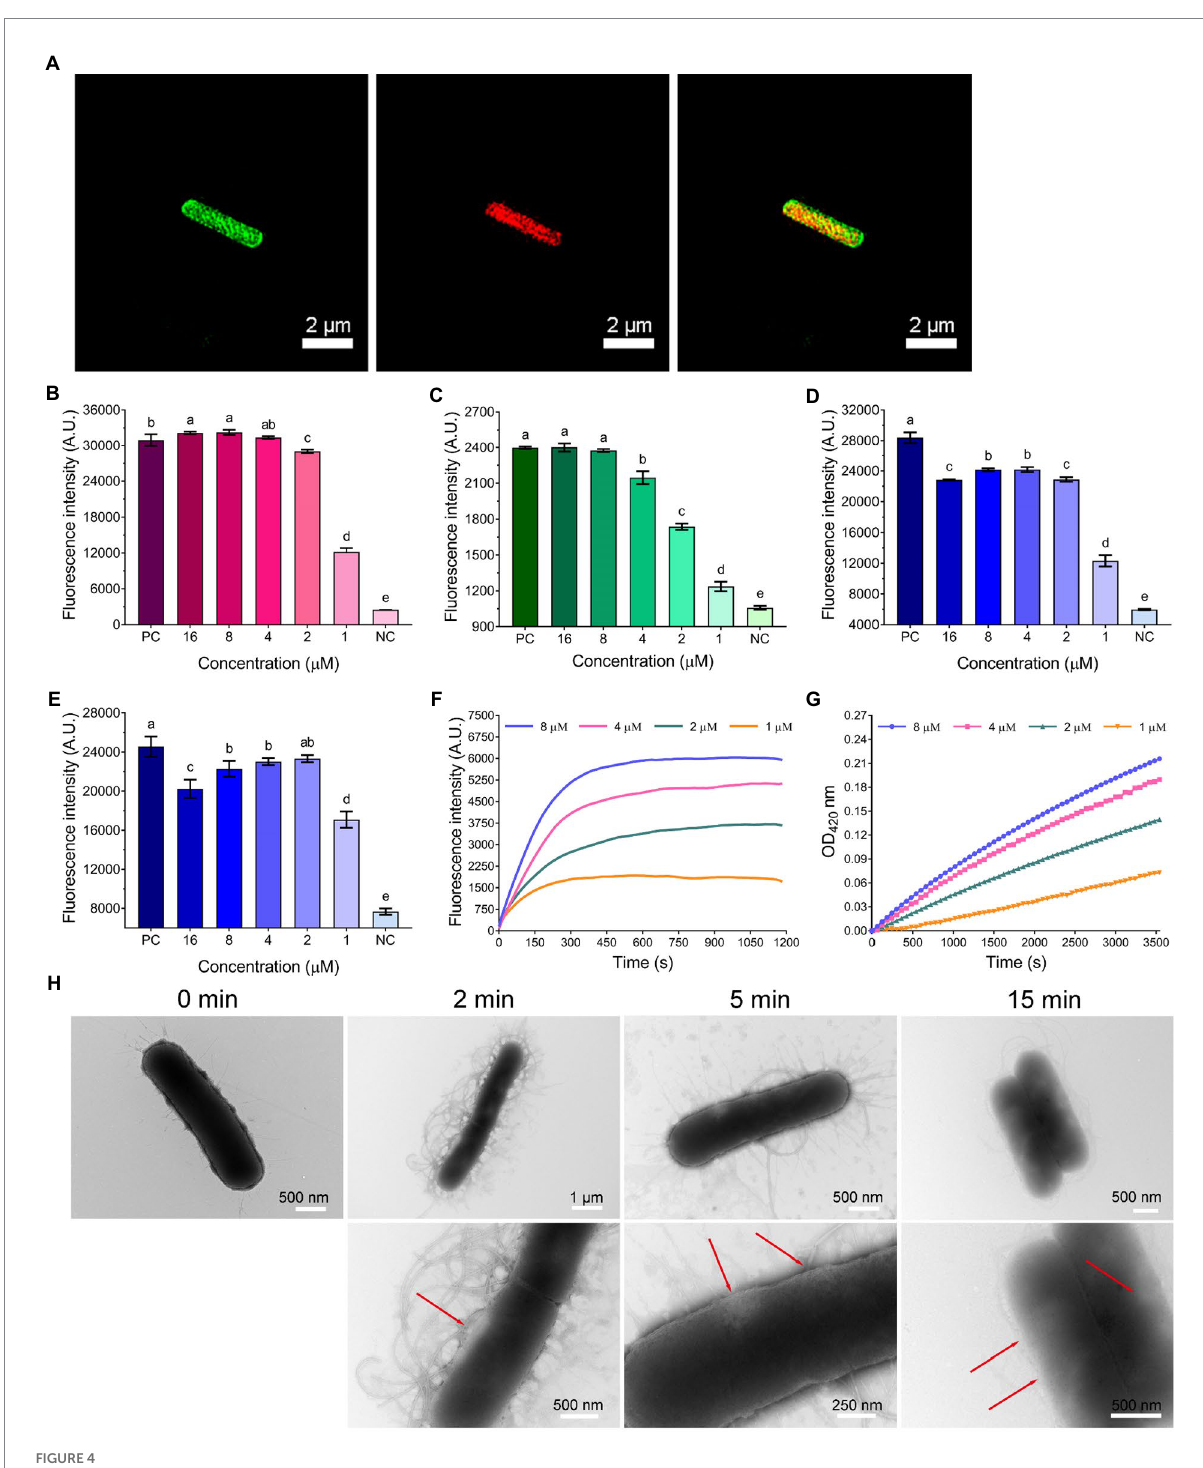
FIGURE 4 (A) 3D-SIM images of E. coli ATCC25922 following treatment with 1 × MIC FITC-labeled WL-C 6 . The green fluorescence signal is the FITC-labeled WL-C 6 , and the red fluorescence signal is the PI fluorescence signal. (B) LPS binding affinities of WL-C 6 . Positive control (PC): polymyxin B (20 μ g/ ml), negative control (NC): 1 × PBS. Data: mean ± SD ( n = 3). (C) Outer membrane permeability induced by WL-C 6 . PC: polymyxin B (20 μ g/ml), NC: 5 mM HEPES (pH = 7.4, containing 5 mM glucose). Data: mean ± SD ( n = 3). (D) LUVs leakage induced by WL-C 6 , the ratio of POPC: POPG is 3:1. PC: Triton X-100 (0.1%), NC: 50 mM Tris–HCl buffer (pH = 7.4). Data: mean ± SD ( n = 3). (E) LUVs leakage induced by WL-C 6 , the ratio of POPC: POPG is 1:3. PC: Triton X-100 (0.1%), NC: 50 mM Tris–HCl buffer (pH = 7.4). Data: mean ± SD ( n = 3). (F) Cytoplasmic membrane depolarization induced by WL-C 6 . (G) Cytoplasmic membrane permeability induced by WL-C 6 . (H) Real-time negative staining TEM observation following WL-C 6 treatment. The values with different superscripted letters (a–e) indicate a significant difference ( p <